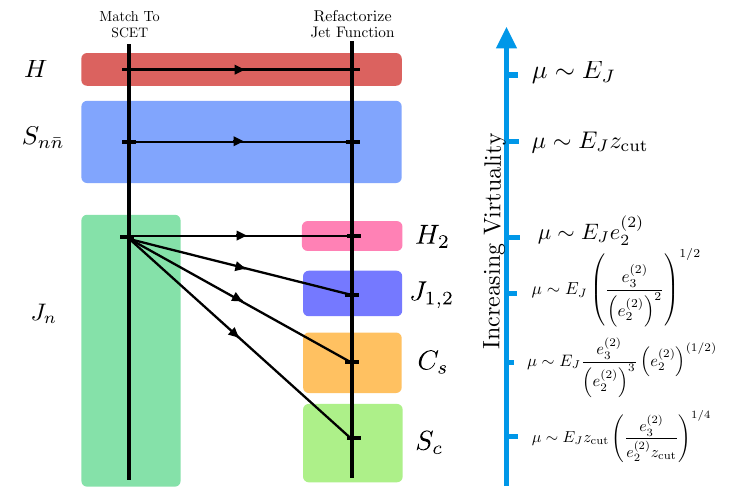
Figure 7. A schematic of the multistage matching procedure in the collinear limit of resolved substructure. The function incorporating non-global collinear e(cid:11)ects is not shown, but is discussed in the